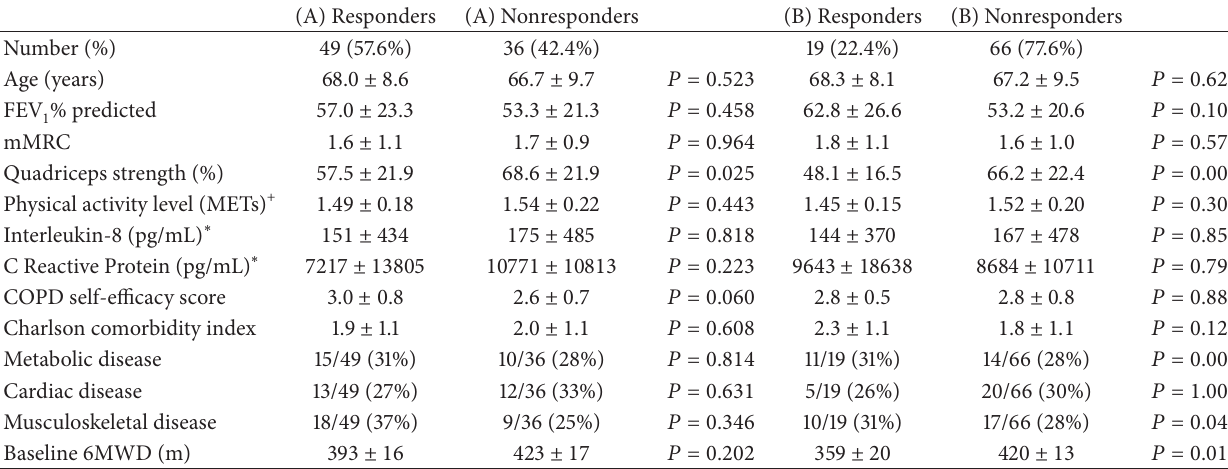
Figure 1: Study flow chart. Table 1: Baseline assessment data for responders compared to nonresponders in the six minute walk